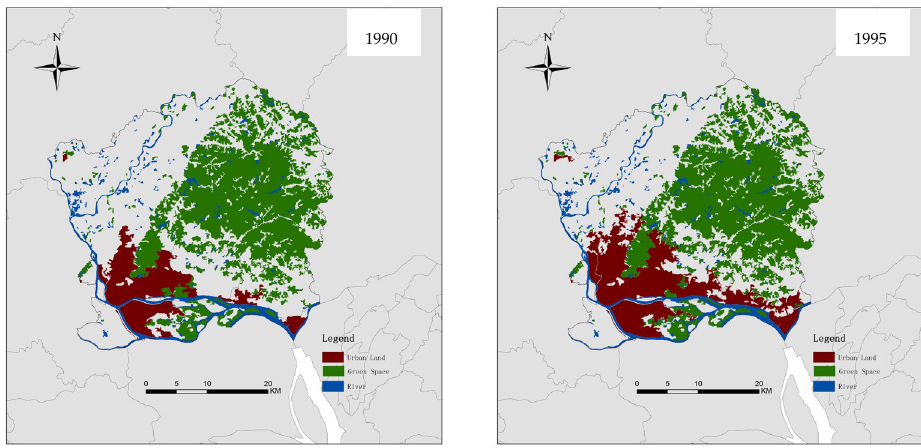
Figure 8. Urban expansion from 1980 to 1990. (Source: drawn by the authors).